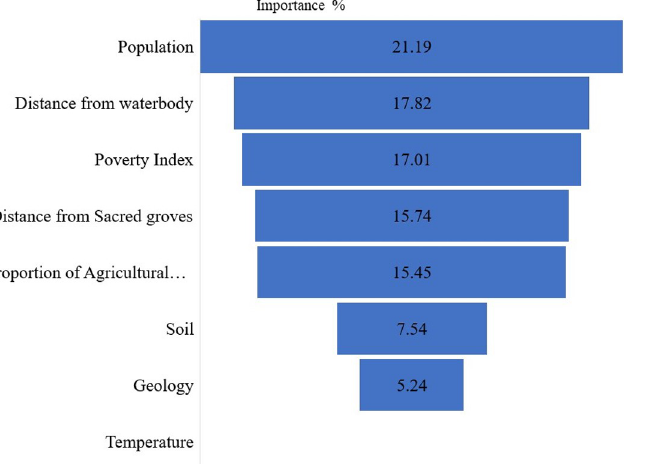
Fig 6. Level of importance for the variables. Source: Authors’ construct, 2021.